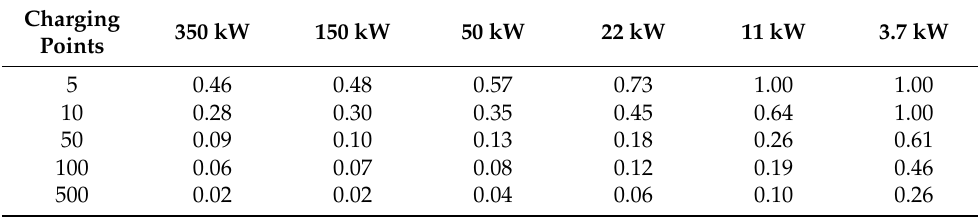
Table A5. Demand factors for the area type “Rural Region: Central City” and six charging